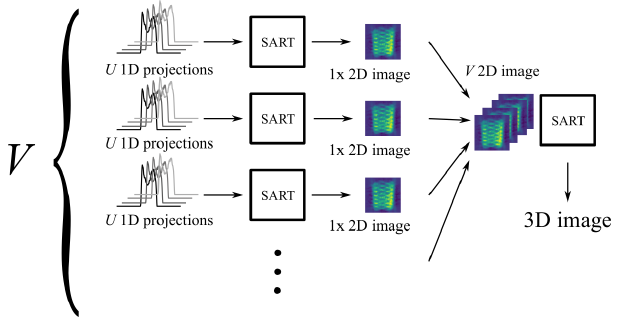
Figure 7. Qualitative comparison of resolution and signal-to-noise ratio for different sliding window sizes using a 1D image of the phantom. Panel (a) shows the result of the sliding window algo- rithm with a small window size, yielding a low-resolution image with a high signal-to-noise ratio. Panel (b) shows the result of the same process with a longer sliding window, resulting in a spectrum with higher resolution but lower signal-to-noise ratio as compared to panel (a) .